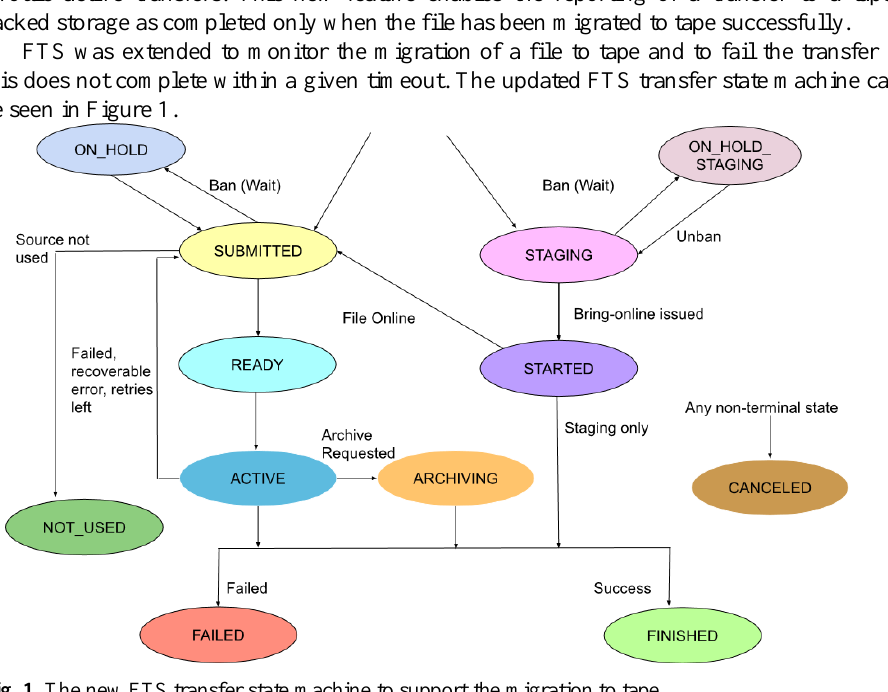
Fig. 1. The new FTS transfer state machine to support the migration to